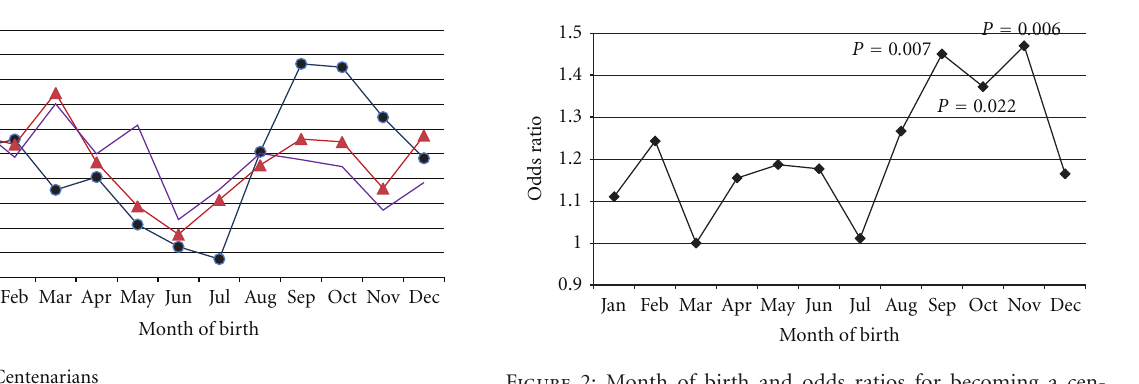
Figure 2: Month of birth and odds ratios for becoming a cen- tenarian. A within-family-study of centenarians and their siblings survived to age 50 (9,724 studied persons). Being born in March is used as a reference level. Unadjusted P values are